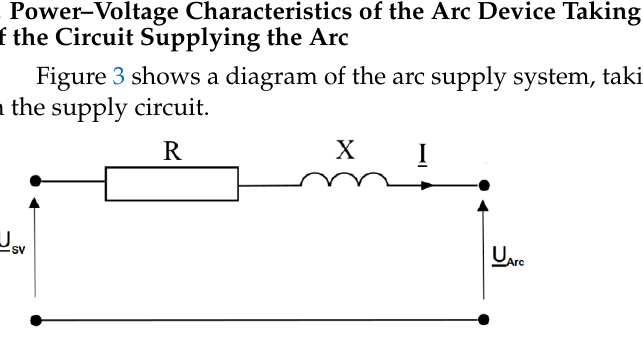
Figure 2. Changes in the arc voltage as a function of the arc device current for two different re- sistance values of the arc-supplying circuit.